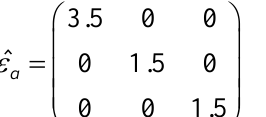
1.76 k d d + ≈ . Only the 0 1 2